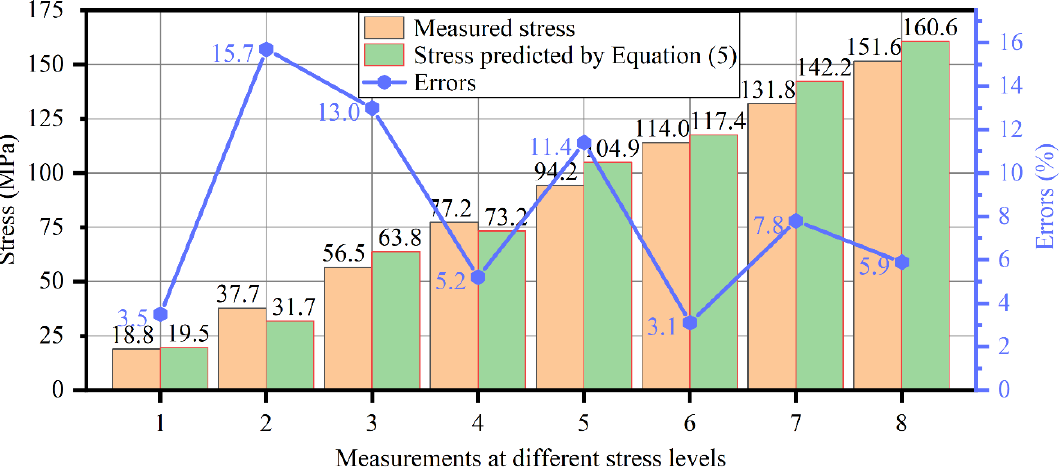
Figure 8. Comparison between stresses predicted by Equation (5) and those measured by strain gauges.